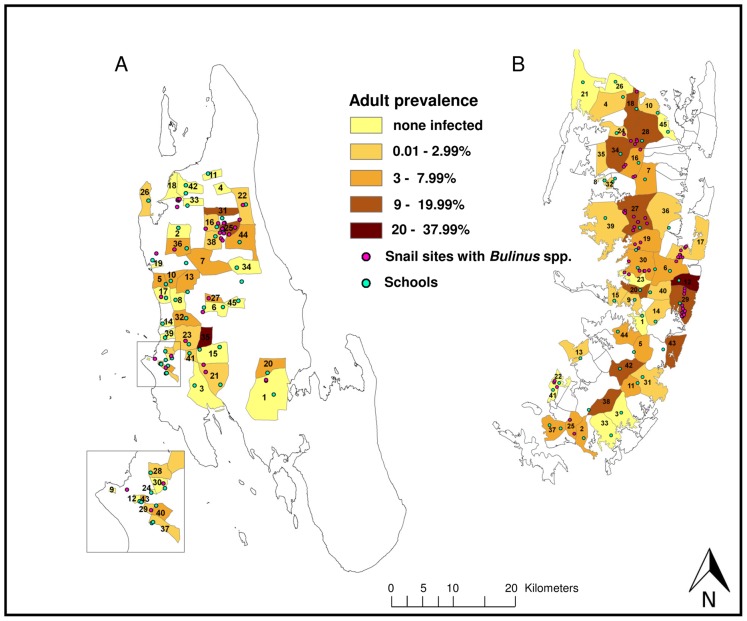

S. haematobium prevalence in adults in 45 study shehias in Unguja (A) and Pemba (B).Map indicating the S. haematobium prevalence in the adult population of the 45 study shehias in Unguja (A) and Pemba (B) at the baseline survey conducted in November/December 2011, surveyed schools in all 45 study shehias per island and sites in the 15 snail control shehias per island, where Bulinus spp. snails were found. Shehias in Unguja and their assigned intervention: Biannual mass drug administration with praziquantel: 1 = Cheju, 2 = Donge Mnyimbi, 3 = Fuoni Kibondeni, 4 = Gamba, 5 = Kama, 6 = Kiboje Mkwajuni, 7 = Kitope, 8 = Mbuzini, 9 = Mchangani, 10 = Mfenesini, 11 = Mkwajuni, 12 = Muungano, 13 = Mwakaje, 14 = Mwanyanya, 15 = Ubago; biannual mass drug administration with praziquantel plus snail control: 16 = Bandamaji, 17 = Chuini, 18 = Donge Mchangani, 19 = Fujoni, 20 = Jendele, 21 = Jumbi, 22 = Kandwi, 23 = Kianga, 24 = Kilimahewa Juu, 25 = Kinyasini, 26 = Mafufuni, 27 = Miwani, 28 = Mtopepo, 29 = Nyerere, 30 = Welezo; biannual mass drug administration with praziquantel plus behaviour change interventions: 31 = Chaani Kubwa, 32 = Dole, 33 = Donge Mtambile, 34 = Kilombero, 35 = Koani, 36 = Mahonda, 37 = Melinne, 38 = Mgambo, 39 = Mtoni, 40 = Mwanakwerekwe, 41 = Mwera, 42 = Pale, 43 = Sebleni, 44 = Upenja, 45 = Uzini. Shehias in Pemba and their assigned intervention: Biannual mass drug administration with praziquantel: 1 = Chanjaani, 2 = Kangani, 3 = Kiwani, 4 = Konde, 5 = Matale, 6 = Ole, 7 = Pandani, 8 = Selemu, 9 = Tibirinzi, 10 = Tumbe, 11 = Ukutini, 12 = Uwandani, 13 = Wambaa, 14 = Wawi, 15 = Wesha; Biannual mass drug administration with praziquantel plus snail control: 16 = Finya,17 = Kangagani, 18 = Kinowe, 19 = Kisiwani, 20 = Kwale, 21 = Makangale, 22 = Makombeni, 23 = Mbuzini, 24 = Mgogoni, 25 = Mkanyageni, 26 = Msuka, 27 = Piki, 28 = Shumba Viamboni, 29 = Vitongoji, 30 = Ziwani; biannual mass drug administration with praziquantel plus behaviour change interventions: 31 = Chambani, 32 = Jadida, 33 = Kengeja, 34 = Kinyasini, 35 = Kizimbani, 36 = Mchangamdogo, 37 = Michenzani, 38 = Mtambile, 39 = Mtambwe Kusini, 40 = Ng'ambwa, 41 = Ng'ombeni, 42 = Ngwachani, 43 = Pujini, 44 = Shungi, 45 = Sizini.